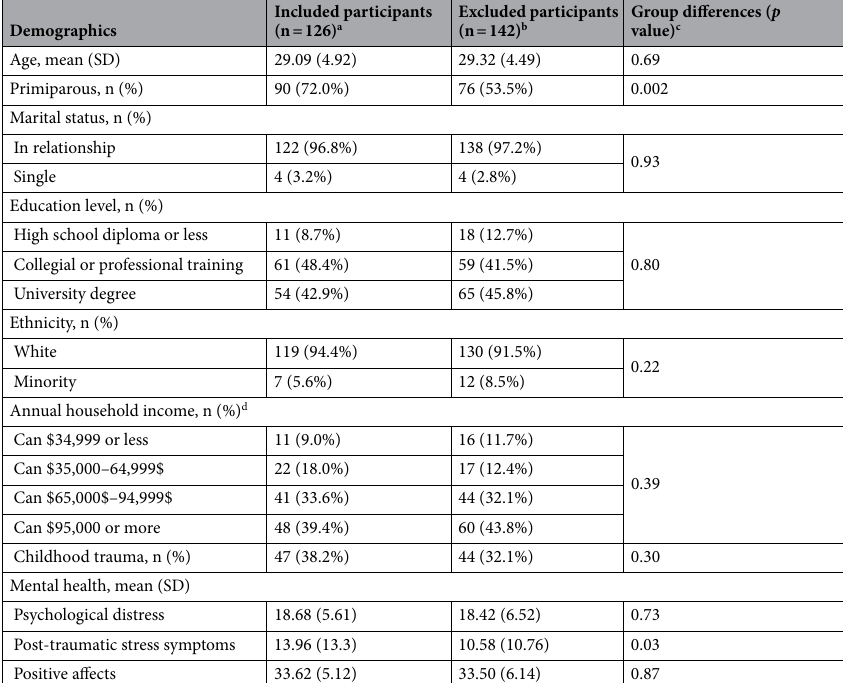
Table 1. Demographic and clinical characteristics of all women enrolled in the study who completed baseline data (N = 268). a Participants were included in the study if they showed some interest in the intervention. b Participants were excluded from the present study when they refused to partake in the intervention protocol but accepted to complete research assessments. c Two-sided p -values were obtained from t -tests for continuous variables and Chi-square tests for categorical variables. d Nine participants did not report annual household income and eight participants did not complete baseline assessment of childhood trauma (missing